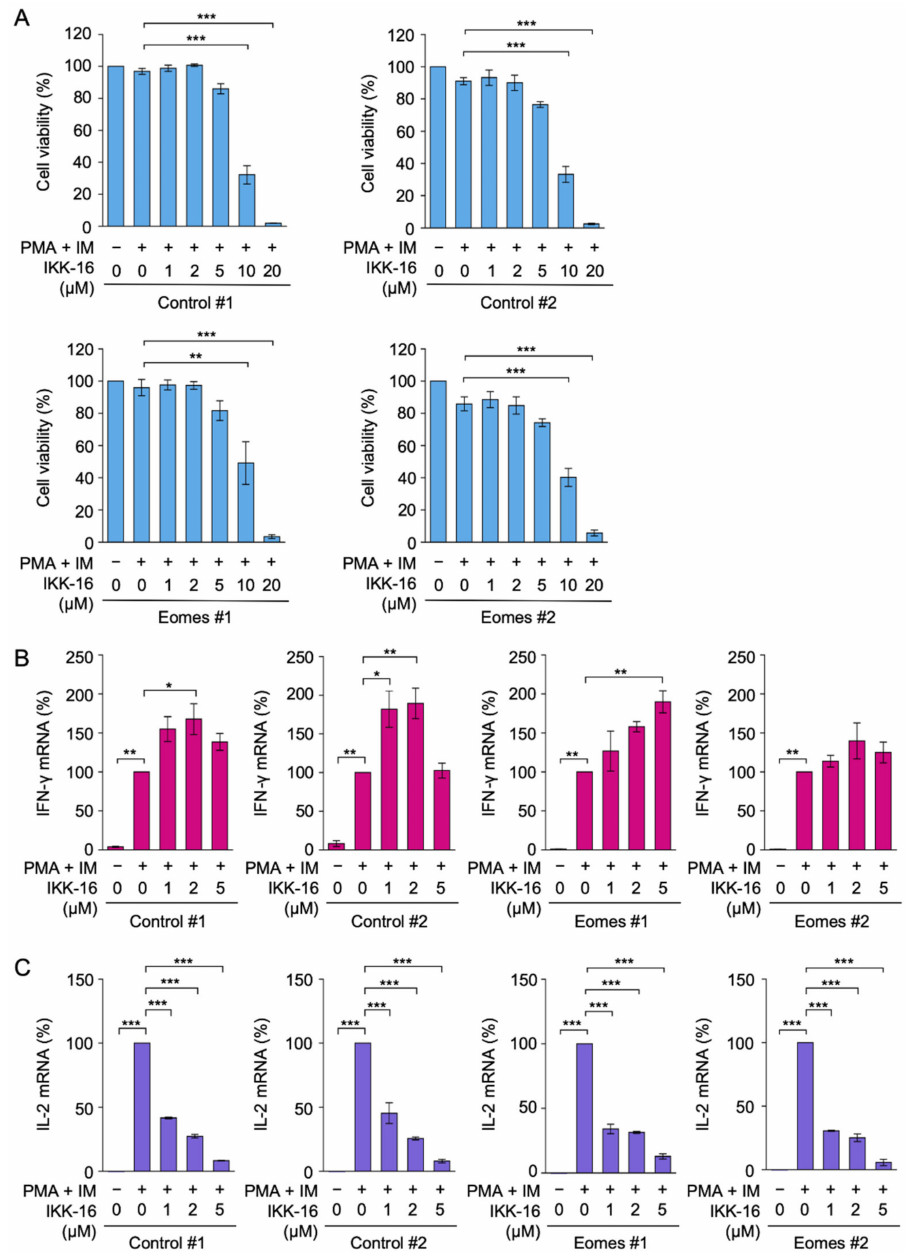
Figure 4. Effects of IKK-16 on IFN- γ and IL-2 mRNA expression in EL4 transfectants. ( A – C ) Control #1, Control #2, Eomes #1, and Eomes #2 EL4 transfectants were pretreated with IKK-16 for 1 h and then treated with (+) or without ( − ) PMA (10 nM) and IM (1 µ M) for 2 h in the presence or absence of IKK-16 at the indicated final concentrations. Cell viability (%) is shown as the mean ± S.E. of three independent experiments ( A ). IFN- γ mRNA ( B ) and IL-2 mRNA ( C ) were measured by quantitative PCR. mRNA levels with PMA and IM in each EL4 transfectant were set to 100%. IFN- γ mRNA (%) and IL-2 mRNA (%) are shown as the mean ± S.E. of three independent experiments. * p < 0.05, ** p < 0.01, and *** p <